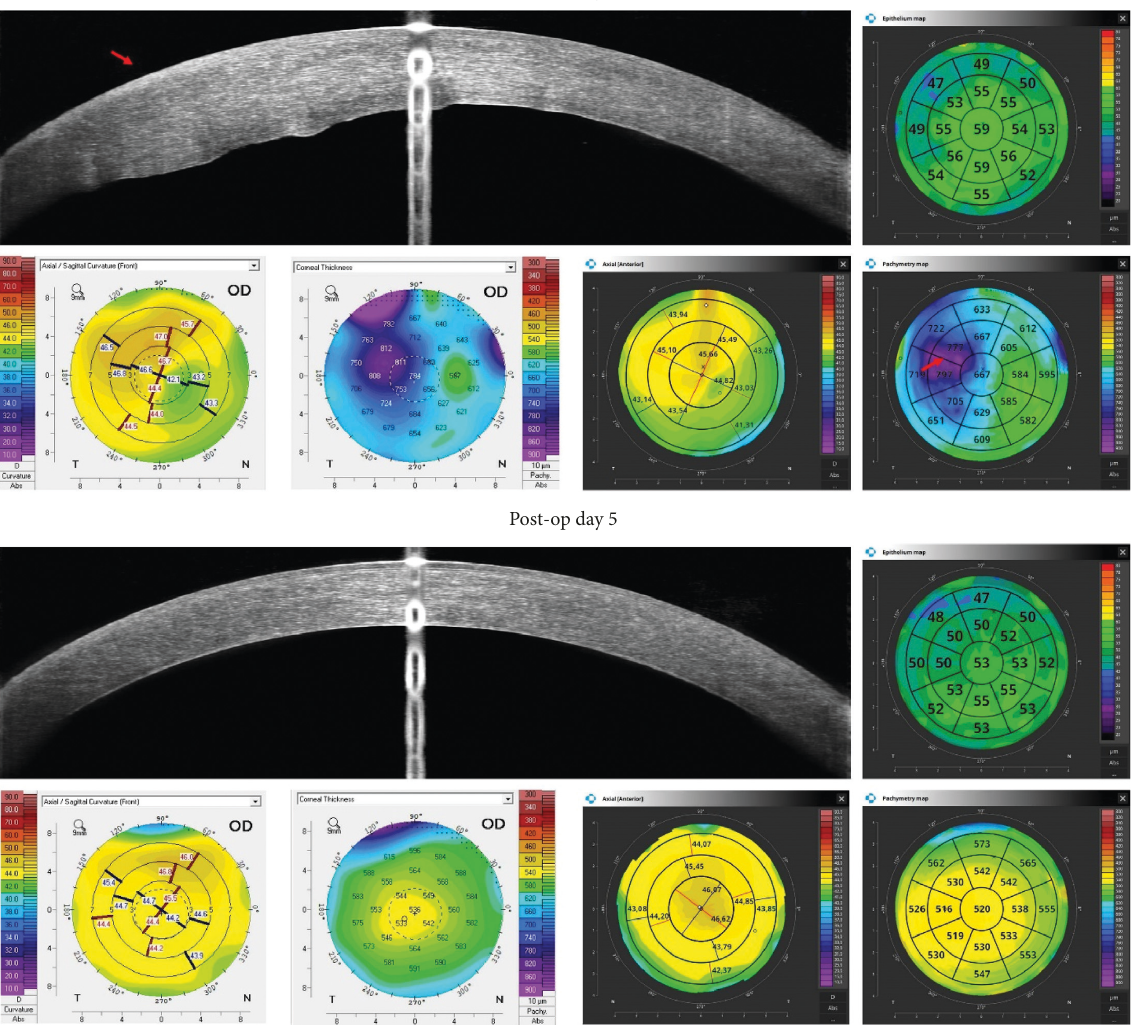
Figure 7: Condition after cataract surgery. On postop day 1, corneal oedema is visible on the pachymetry map (red arrow) and a disruption of the regularity of the anterior corneal surface can be observed on the result of corneal topography. On postop day 5, the oedema regressed. Despite a significant change in the corneal thickness and curvature between examinations, ETMs show a similar image. The measurements performed with Pentacam have a white background, and the ones performed with REVO NX have a black